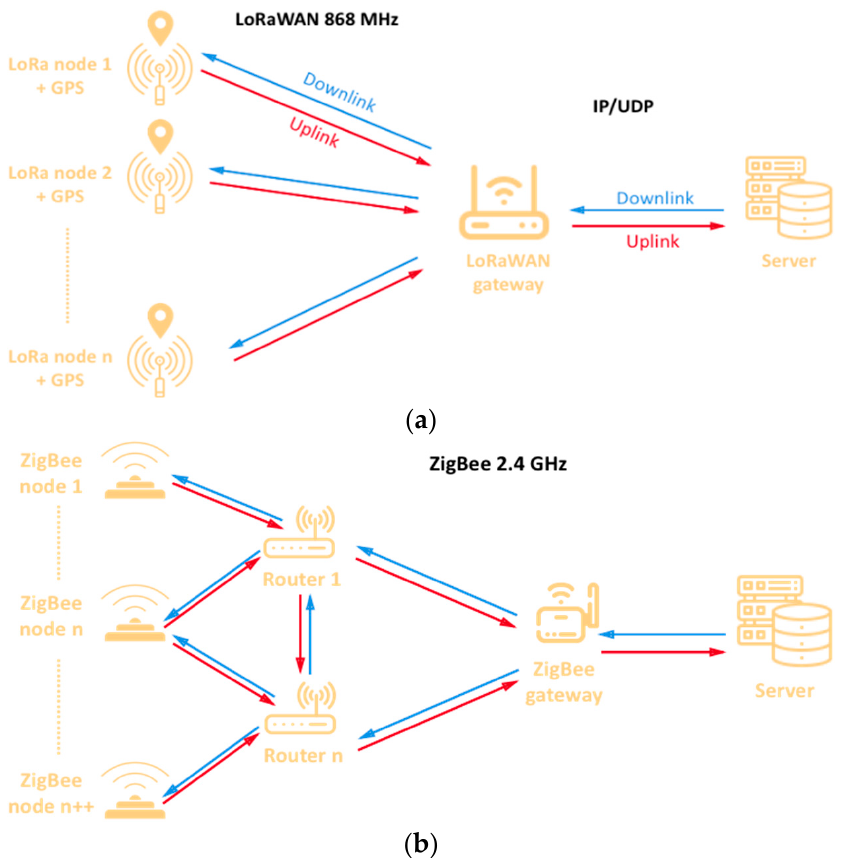
Figure 9. Schematic representation of the network topologies to be deployed on the golf course, ( a ) LoRaWAN and ( b ) ZigBee.